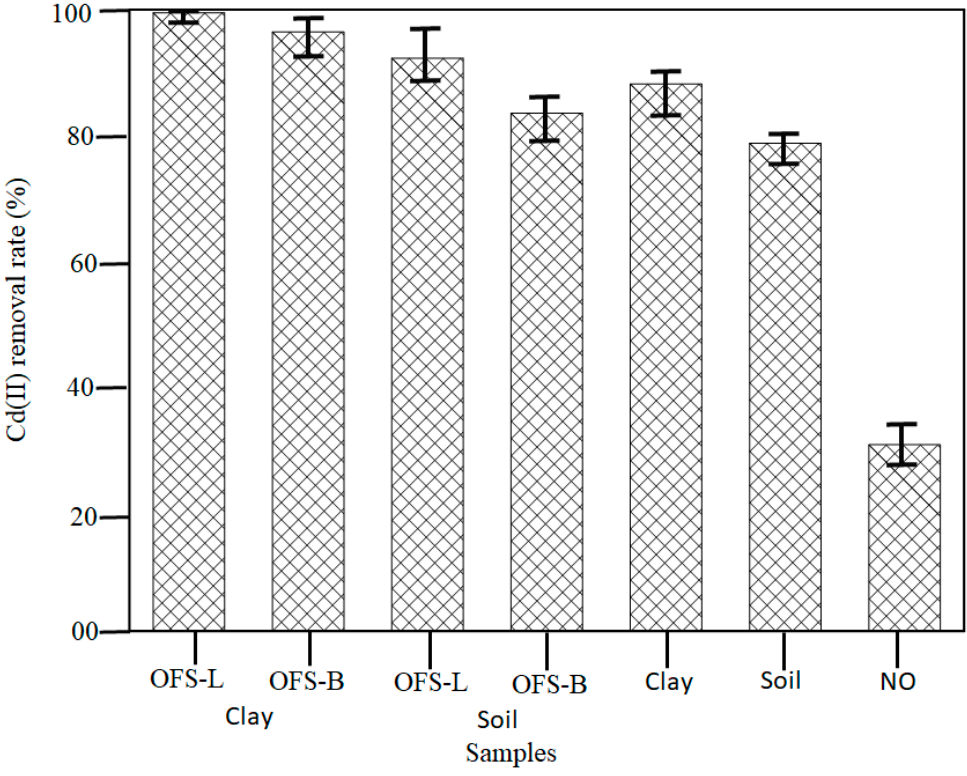
Figure 4. Cd (II) removal rates on day 3 of bioretention system using clay and soil samples. 3.3. Mobility and Adsorption of Cd (II) in Each Layer of Bioretention System